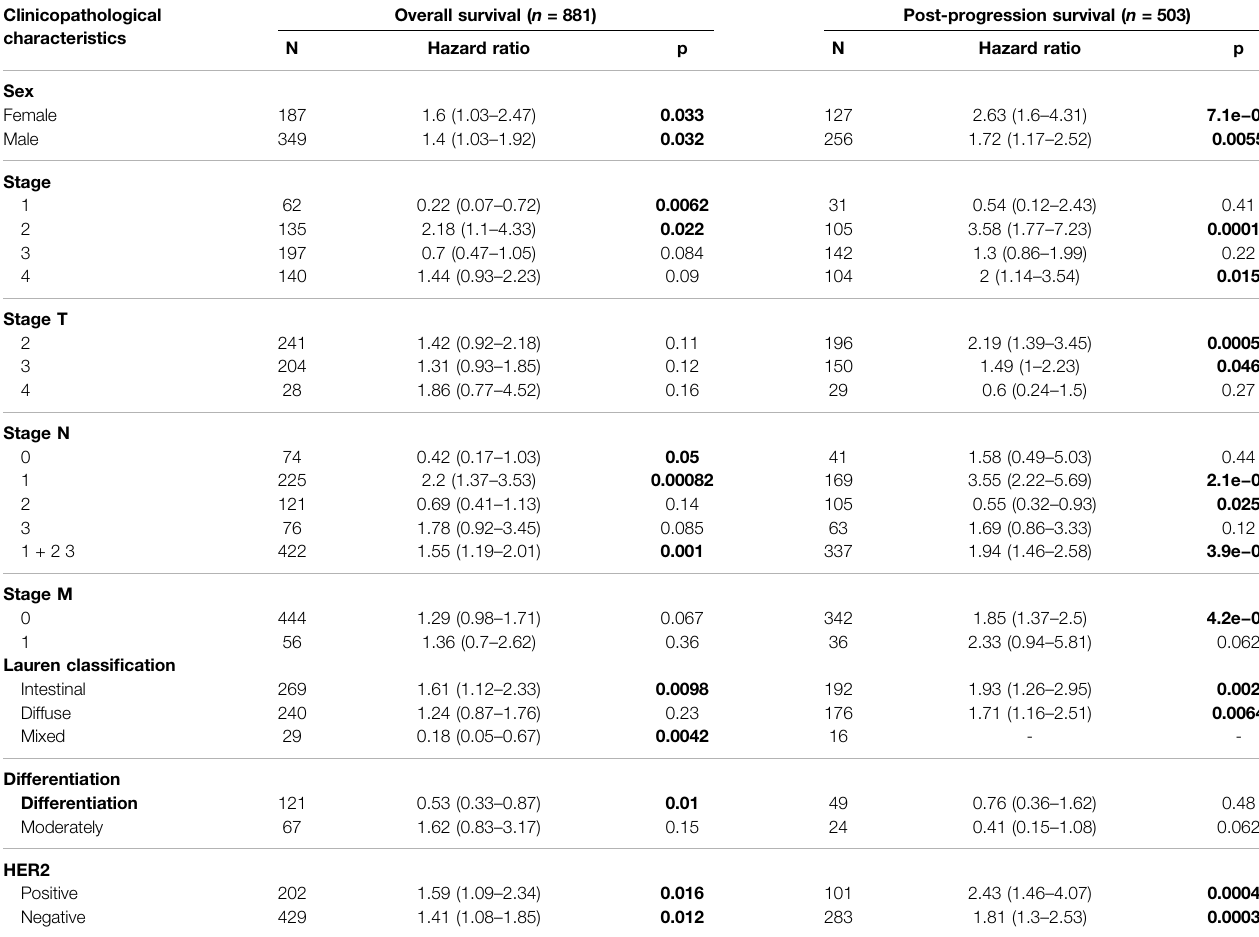
TABLE 1 | Correlation ofintegrin alphaL (ITGAL) mRNAexpressionand clinical prognosis in gastric cancerwithdifferent clinicopathological factors byKaplan – Meier plotter. Clinicopathological